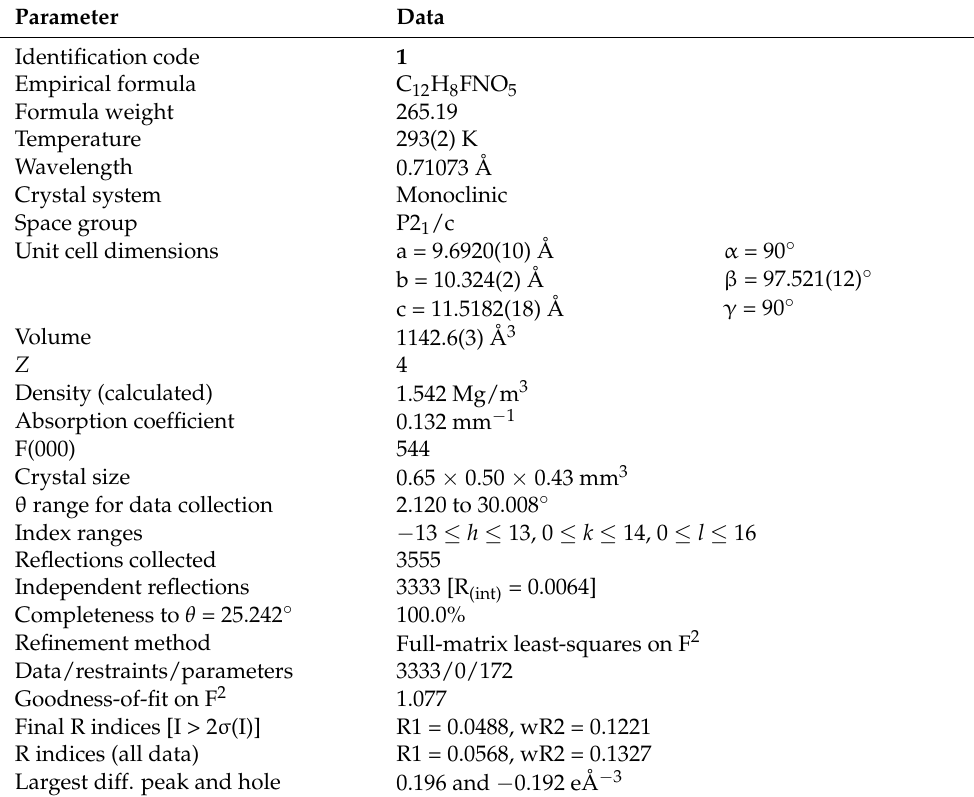
Table 4. Summary of the crystallographic data and refinement statistics for 1 .